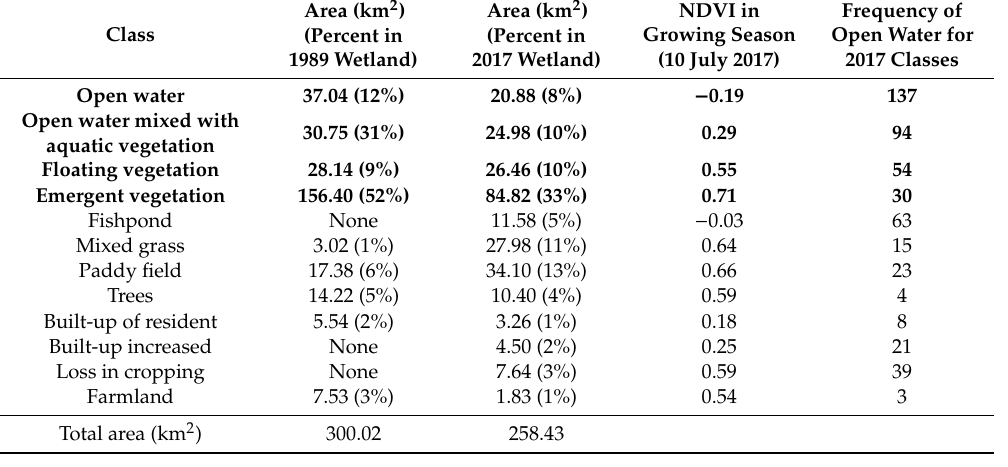
Table 1. Statistics for the classes in the wetland range of 2017.